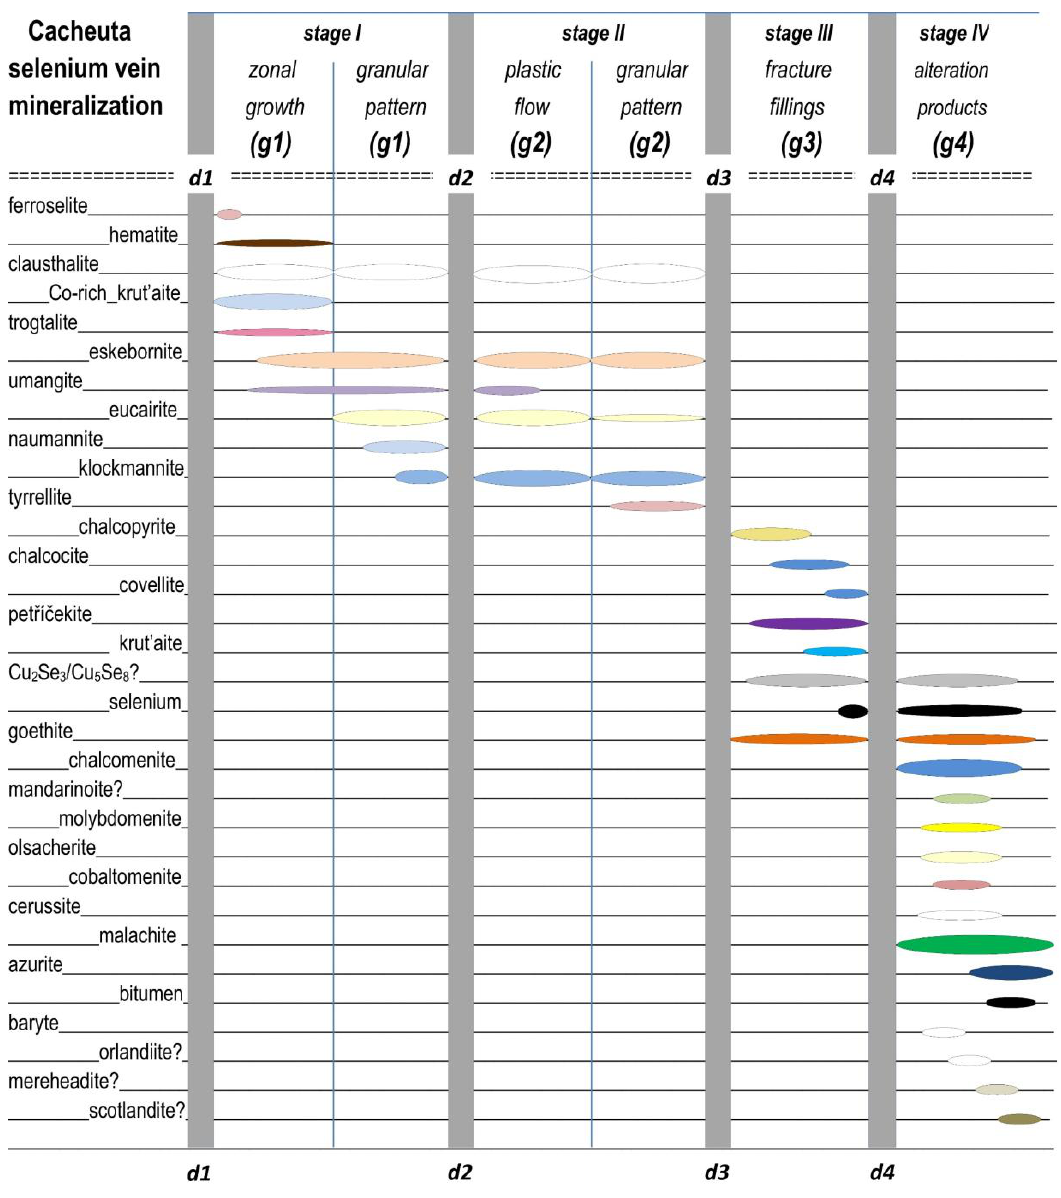
Figure 6. Paragenetic sequence and crystallization/deformation diagram for the Sierra de Cacheuta selenium mineralization.